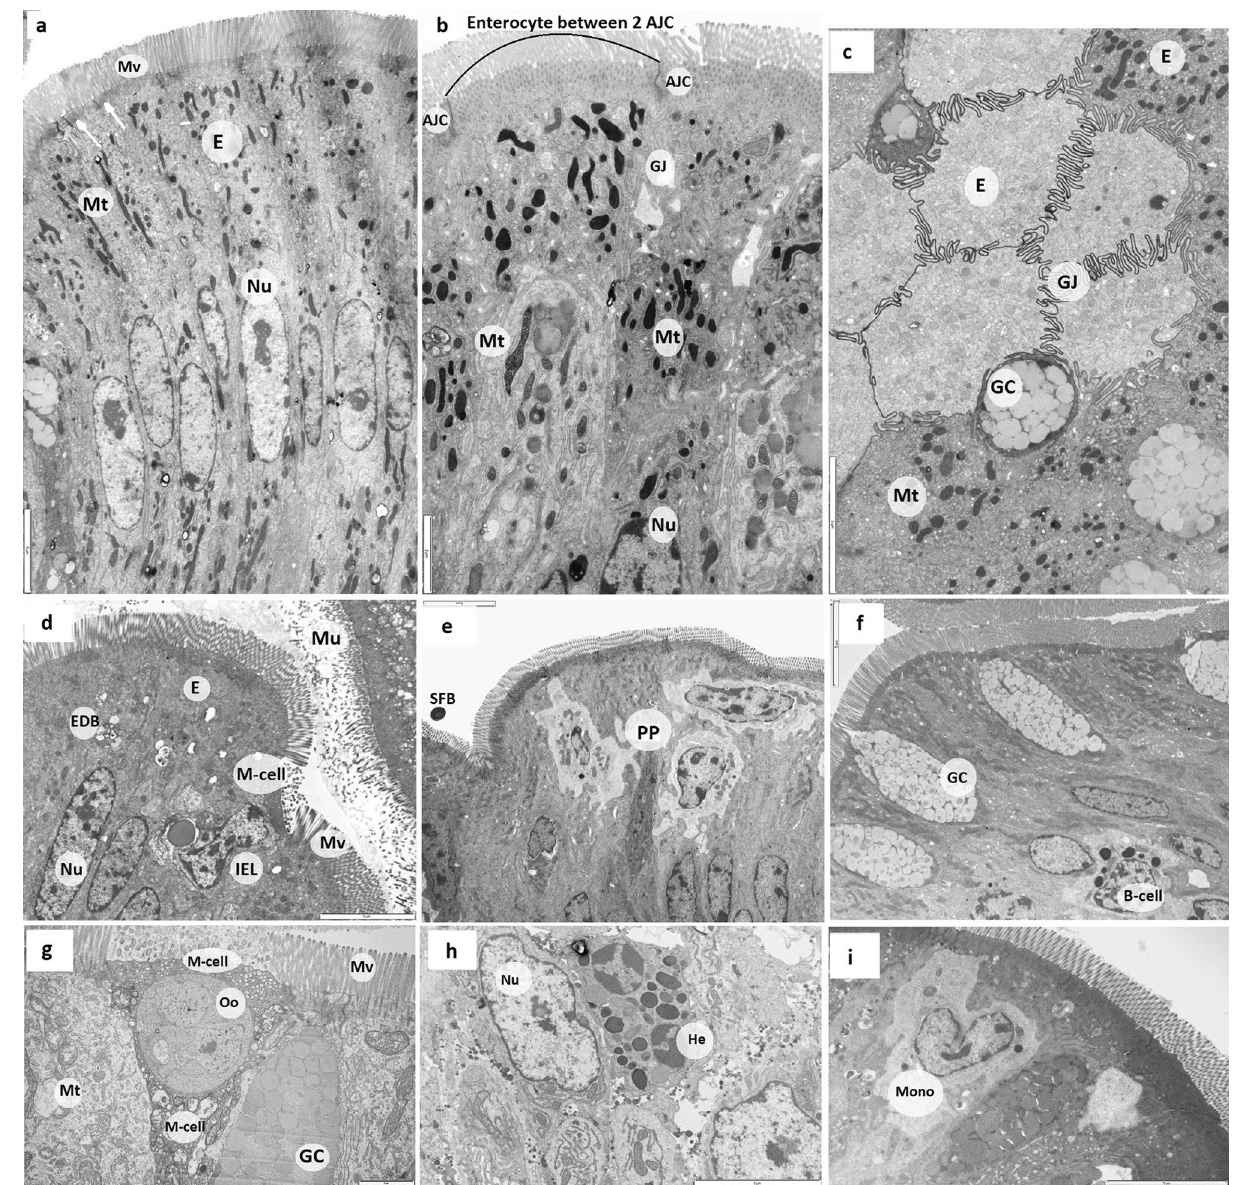
Figure 5. Transmission electron micrographs showing the architecture of intestinal epithelial cells and several types of immune cells in the ileum from 21 d old chicks. Image a is from a control chick, b and f are from a NE & H57 chick, and c , d , e , g , h and i from NE chicks. Images ( a , b & c ) show the ultrastructure of ileal epithelial cells, enterocytes (E), and their content: nucleus (Nu), mitochondria (Mt), microvilli (Mv) and the apical junctional complex (AJC) and gap junction (GJ). Image a show actin condensation in the AJC area (white arrows). Identified also are goblet cells (GC) that secrete mucin granules providing the mucosal surfaces with a thick mucus layer (Mu). Note a cross-sectional image of villus tip (image c) showing some light and dark enterocytes, and GC and GJ between adjacent cells. Images ( d , e , f , g , h and i ), show several leukocyte populations that can be found in the epithelium of the ileum, including intraepithelial lymphocytes (IEL) and microfold cells (M-cells). M-cells are located in the epithelium covering mucosa-associated lymphoid tissues, such as the Peyer’s patches (PP, image e ), and are specialized to sample macromolecules (antigens and pathogens) and transport them to macrophages and other immune cells to process. While the enterocytes possess a dense brush border with long, thin microvilli, M cell have apical microfolds. Image d shows the M-cell bordered by enterocytes and with an engulfed IEL; also the presence of electron dense bodies (EDB) demonstrating ingested bacteria, while image g shows the M-cell that has engulfed an Eimeria oocyte (Oo). Other leukocytes identified are B-cells (or plasma cell) which produce secretory immunoglobulin A (sIgA) a glycoprotein transported across intestinal epithelial cells into gut secretions (image f ), and heterophils (He), which are recruited to inflammatory site to clear pathogens (image h ); mononuclear cells (Mono), e.g. macrophage can also migrate to intraepithelial compartment (image i ). Scale bars are: a , c , d , e , f , g and i = 5 µM; b = 2 µM and h = 3